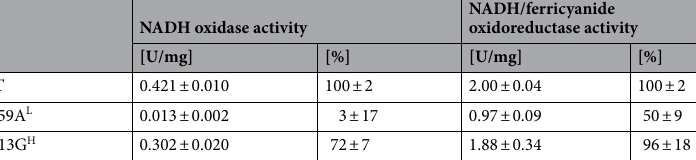
Table 1. NADH oxidase and NADH/ferricyanide oxidoreductase activity of cytoplasmic membranes from E. coli wild type and mutant strains. Data were derived from three biological replicas; each replica was measured in triplicates. The standard deviation of the measurement is